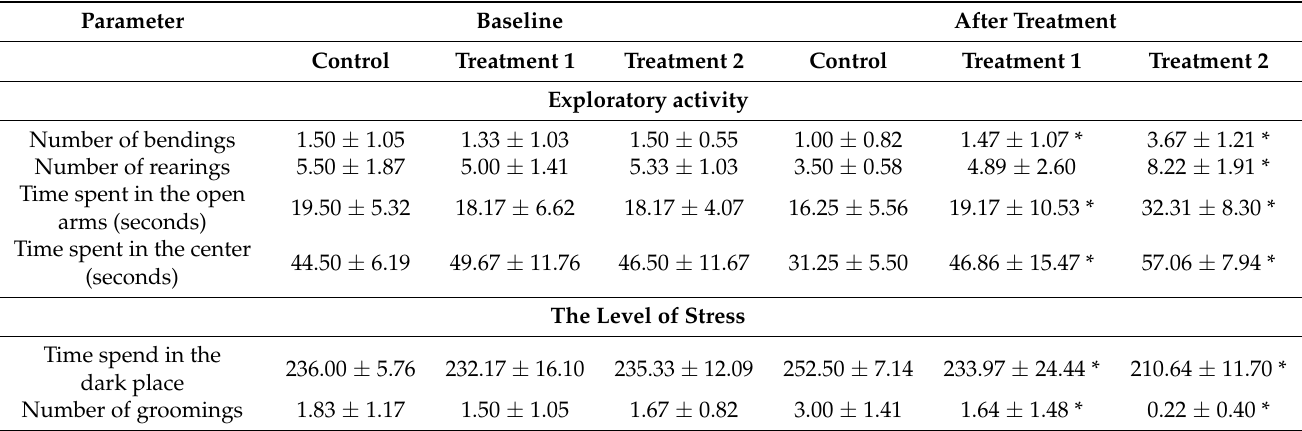
Table 4. Elevated plus-maze tests result expressed as mean ± standard deviation.